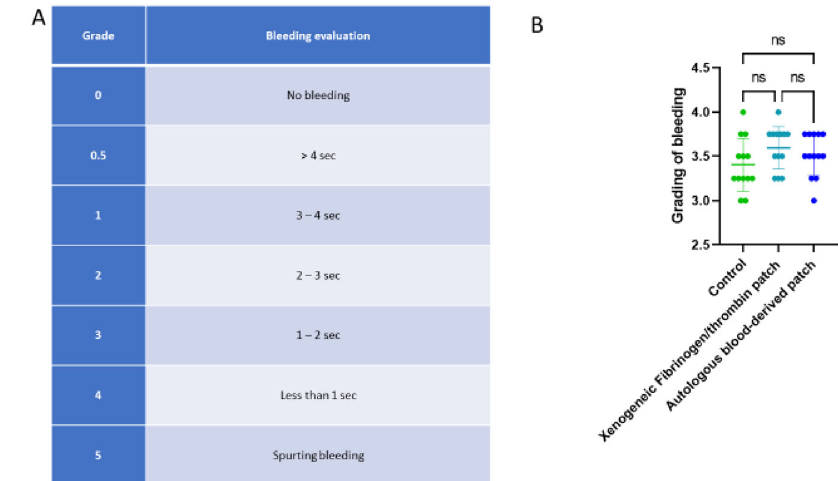
Fig. 3 Bleeding scale and comparison of bleedings between groups before treatment. A Bleeding scale with grades from 0 to 5. Adapted from Katsuyama et al. [42]. B Statistical comparison of bleeding-gradings between groups before treatment. We did not see any signi fi cant difference in the level of bleeding-scores between the groups before treatment (mean score ± SD, autologous patch: 3.52 ± 0.24, xenogeneic fi brinogen/thrombin patch: 3.60 ± 0.24, Control: 3.40 ± 0.30. Friedman test: p = 0.11). ns not signi fi